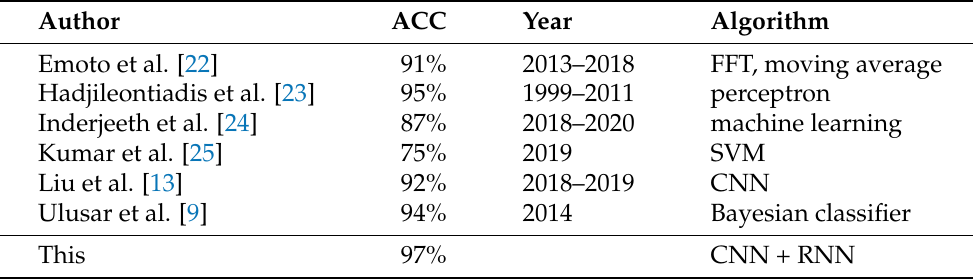
Table 10. Comparison of our algorithm with others (in alphabetical order). We present results provided by